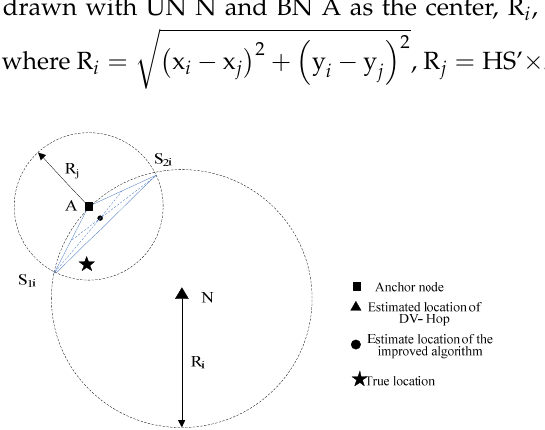
Figure 4. Correction of UN coordination position.